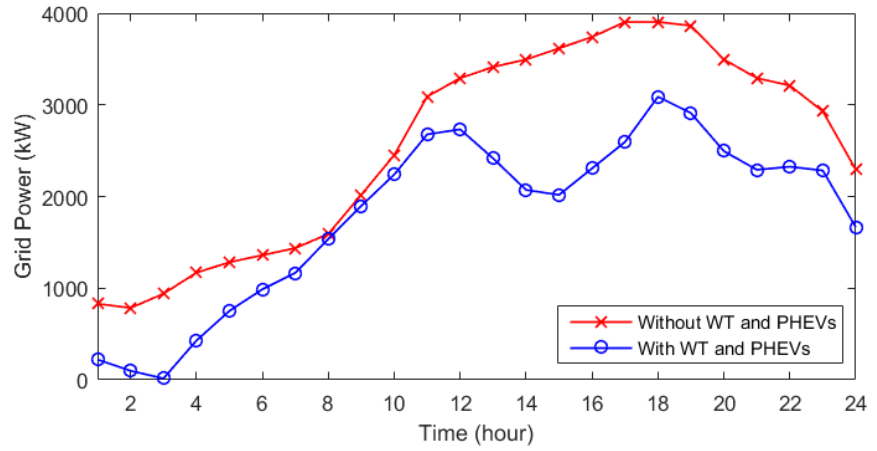
Figure 8. Received grid power with and without WT and PHEVs using the IGJO for 24 h.